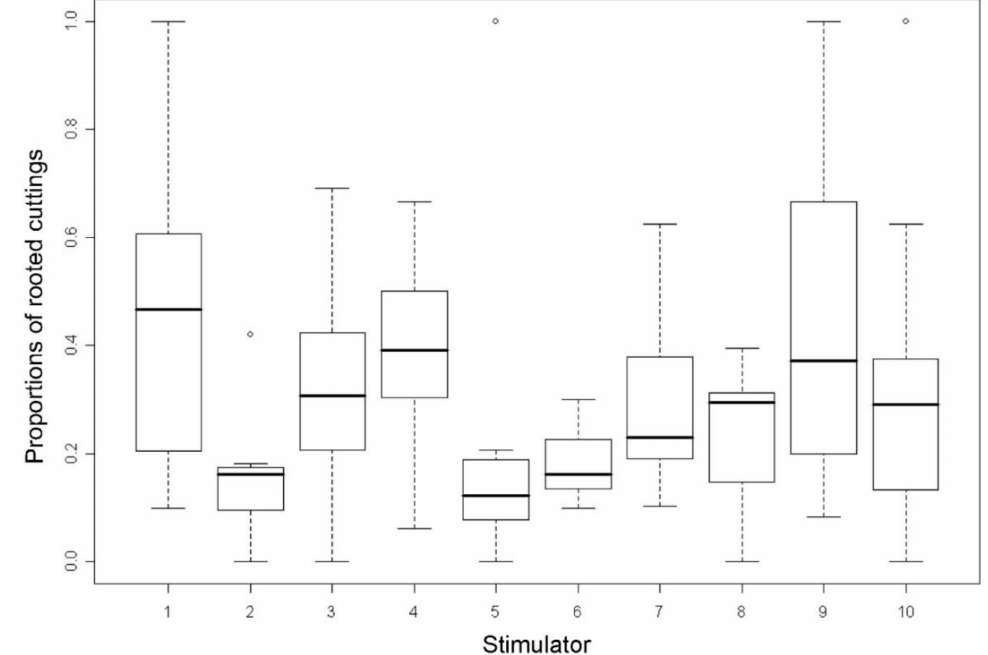
Figure 8. Box plot of the proportions of rooted cuttings from the surviving cuttings in relation to the stimulator. The horizontal line in each box represents the median, the hinges represent the 25th and 75th percentiles, the whiskers represent 1.5 times the interquartile range and open circles represent values outside this